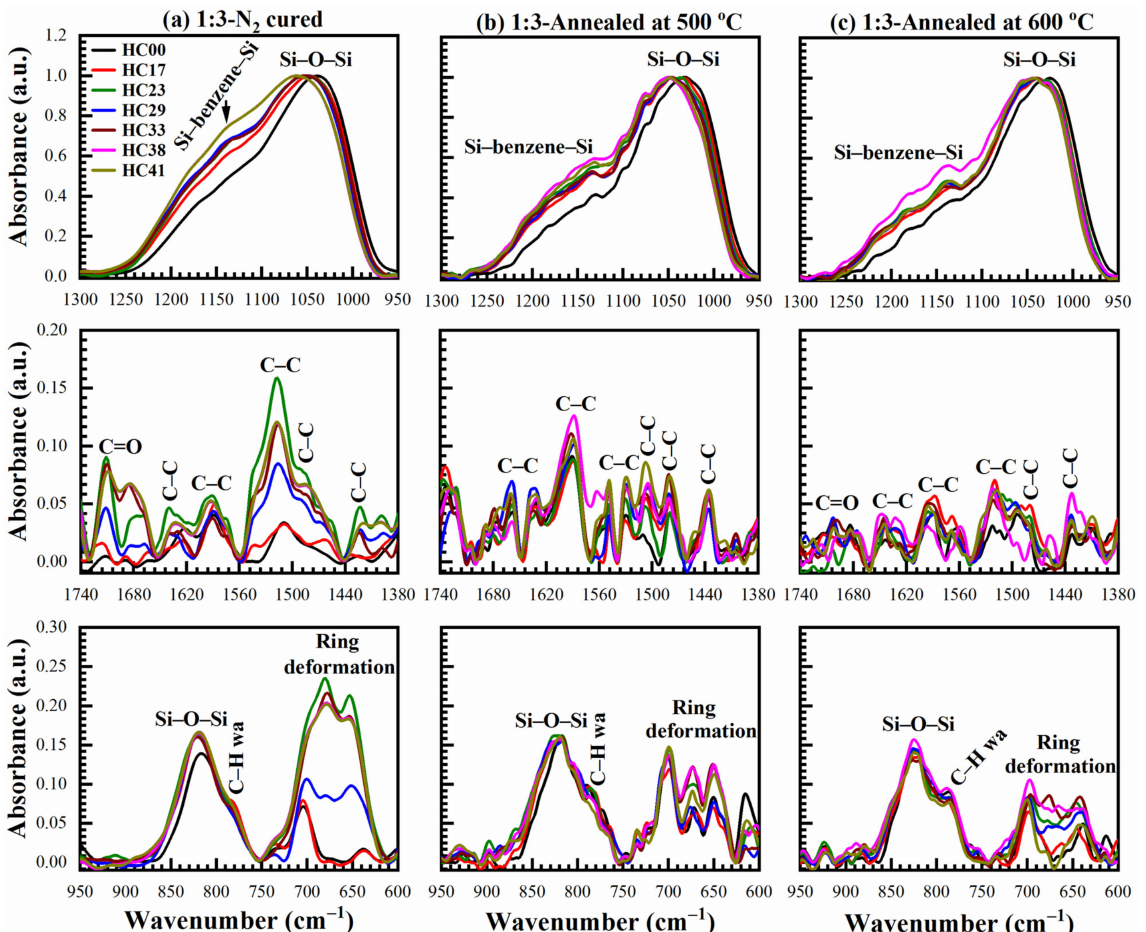
Figure 19. Ranges of FTIR spectra for 1:3 material after ( a ) hard baked (HB) at 400 ◦ C in N 2 for 60 min (N 2 -cured), ( b ) annealing at 500 ◦ C for 30 min, and ( c ) annealing at 600 ◦ C for 30 min with different porogen (0 to 41 wt%, films numbered from HC17 to HC41) loadings.